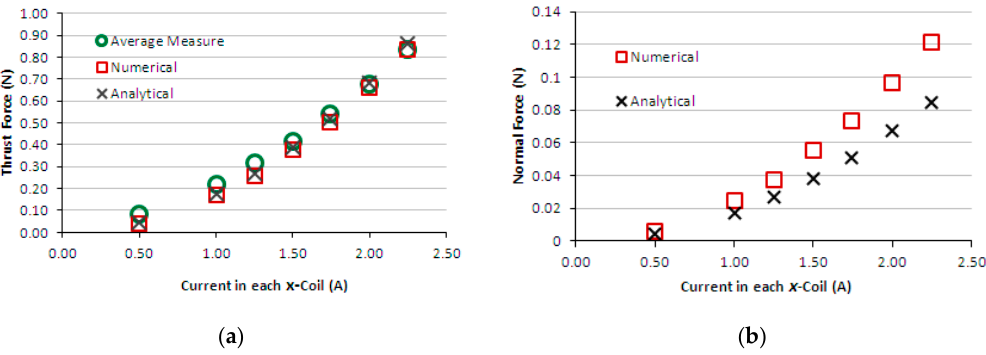
Figure 11. Case 2: ( a ) thrust force and ( b ) normal force produced by the induction planar actuator with only the x -winding excited.